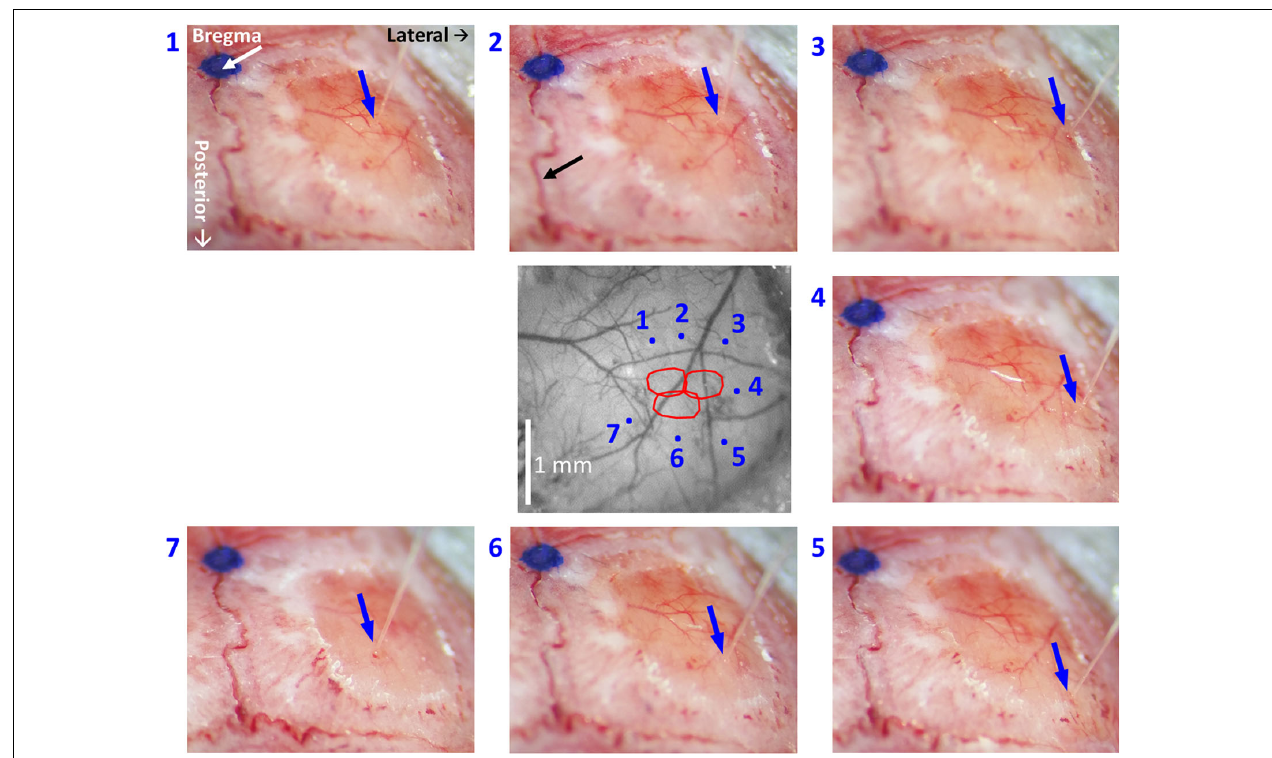
FIGURE 5 | High-resolution images of each individual microinjection location, compared to the corresponding planned site. The image at the center was taken under green light illumination (peak wavelength of 530 nm). It shows the region of interest comprising all the stimulated barrels (red contours, calculated as in Figure 2 , 3 ). Each of the seven images around it was taken after the insertion of the glass micropipette at one of the sites selected for viral micro-injection. The insertion points are indicated by blue arrows. The numbers next to the images of the micropipettes correspond to the microinjection sites displayed in the center image by blue dots. The white arrow in the top-left panel points at a blue dot: this is a fiducial we placed onto the skull to mark the bregma. In the top-middle panel, the black arrow points to the midline suture going posteriorly. The stereotaxic axis directions are marked in the top-left panel. The scale bar represents 1